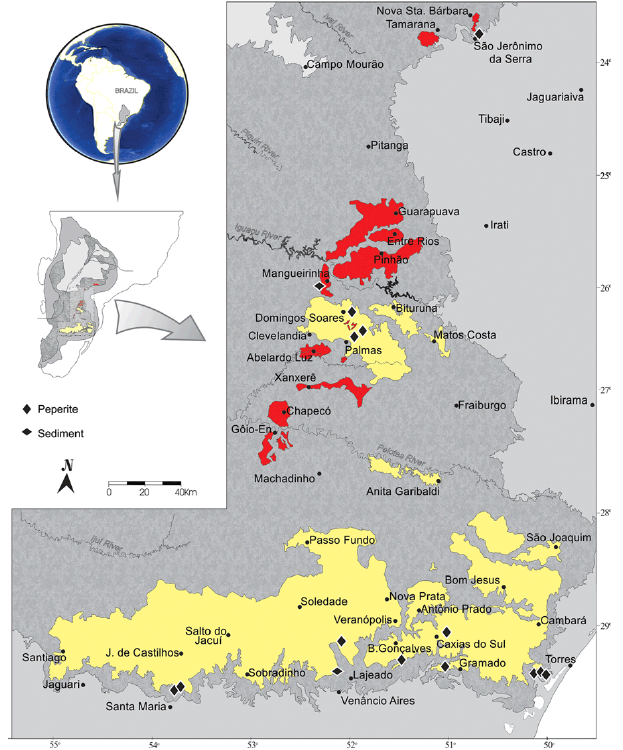
Fig. 3. Map with the location of sediment and peperite outcrops (lozenges) within the Palmas and Chapecó Members: yellow – ATP units; red – ATC units.